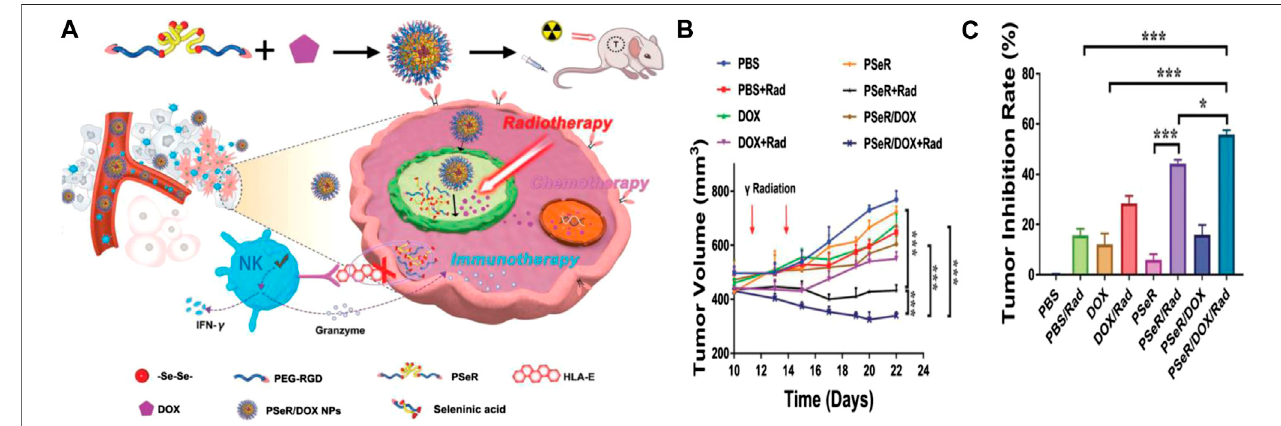
FIGURE 9 | (A) Schematic illustration of the PseR/DOX mechanism of therapeutic action and chemical structure. (B) Curves of tumor volumes following treatment with different PseR-based nanoparticles. (C) Curves of tumor inhibition rates following treatment with different PseR-based nanoparticles (Gao et al., 2020). Copyright 2020, John Wiley and Sons.